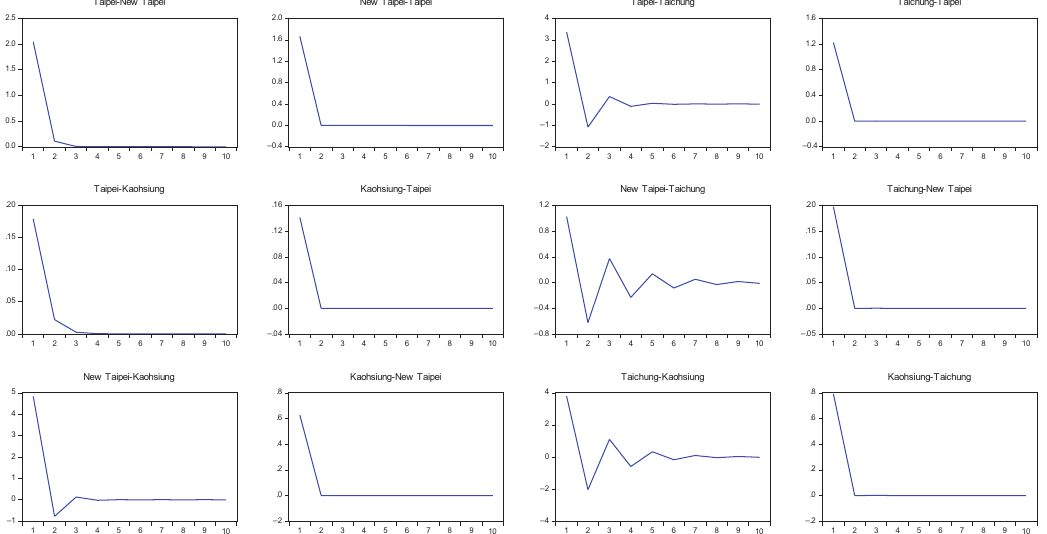
Figure 5. Relationship between city